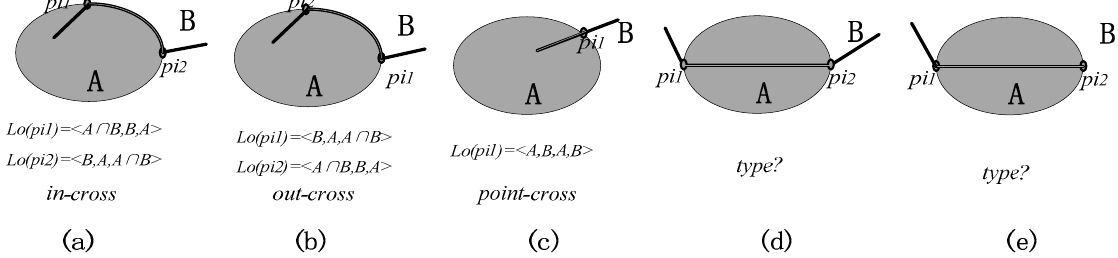
Figure 1. Examples of multiple intersection components between line/region and line/line in OpenStreetMap (OSM) data. ( a ) A lake has multiple intersection components with the same tra- jectory; ( b ) One trajectory multiple intersection components with another trajectory.